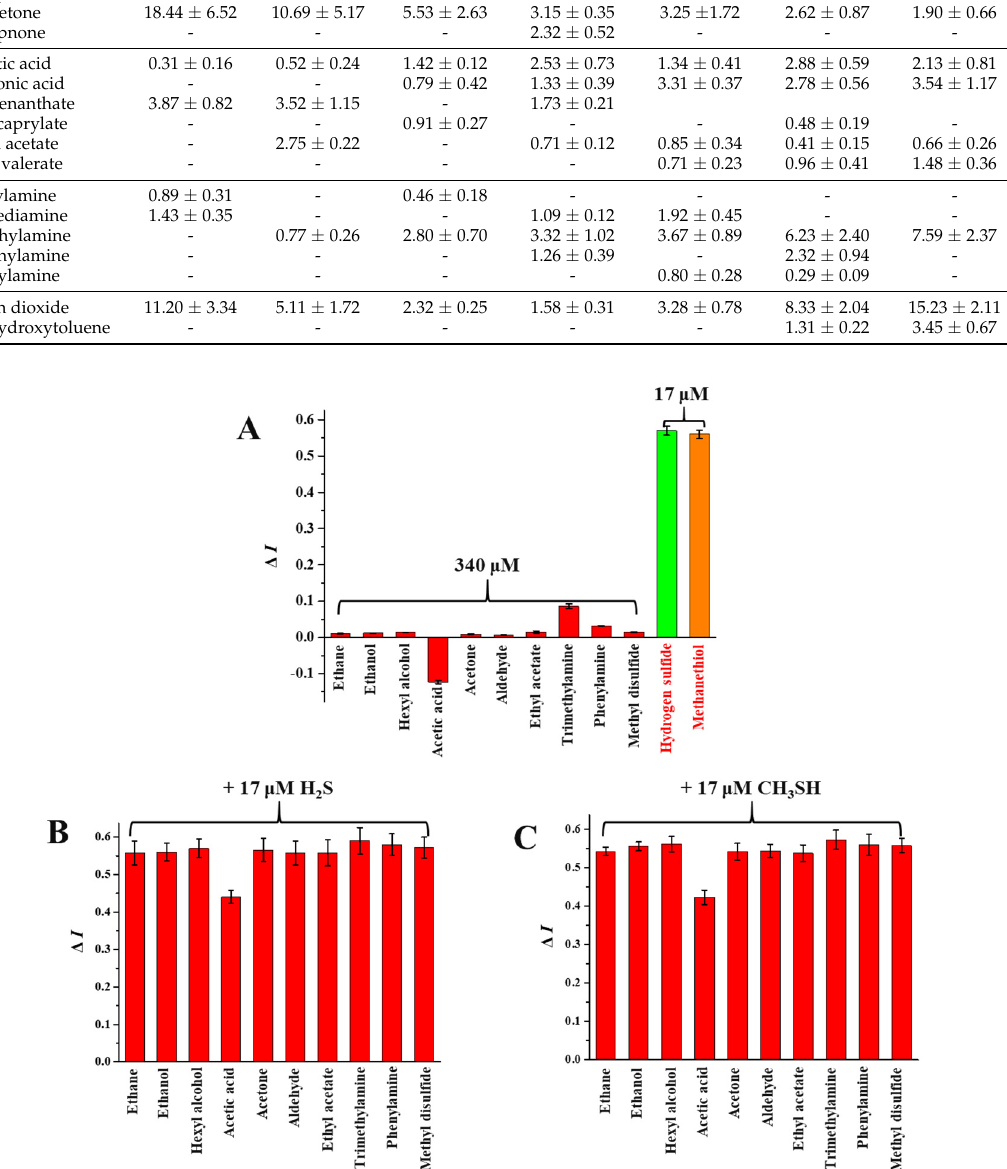
Figure 6. ( A ) The ∆ I values of SiQD-AgNC reacting with 340 µ M of other volatile gases or 17 µ M of H 2 S and CH 3 SH.( B ) The ∆ I values of SiQD-AgNC simultaneously reacting with 340 µ M of other volatile gases in the presence of 17 µ M of H 2 S. ( C ) The ∆ I values of SiQD-AgNC simultaneously reacting with 340 µM of other volatile gases in the presence of 17 µM of CH 3 SH.